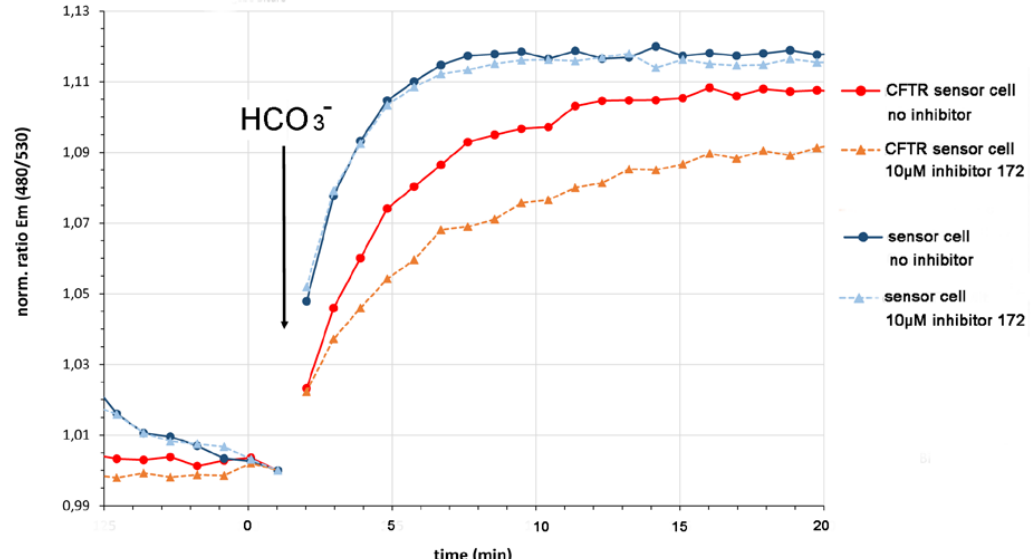
9 of 14 Figure 7. Mechanism of cystic fibrosis transmembrane conductance regulator (CFTR) activation in the sAC-CEPAC-CFTR cell. In the sAC-CEPAC-CFTR cell, CFTR is activated by PKA- (protein kinase A) dependent phosphorylation causing the channel to open. Bicarbonate influx results in cAMP synthesis catalyzed by sAC tr . cAMP activates PKA which in turn activates CFTR through phosphorylation. To distinguish between the CFTR activity and other cellular bicarbonate transport activities we pre-incubated the sAC-CEPAC-CFTR cell with 10 µm of the CFTR-specific inhibitor 172 in sodium